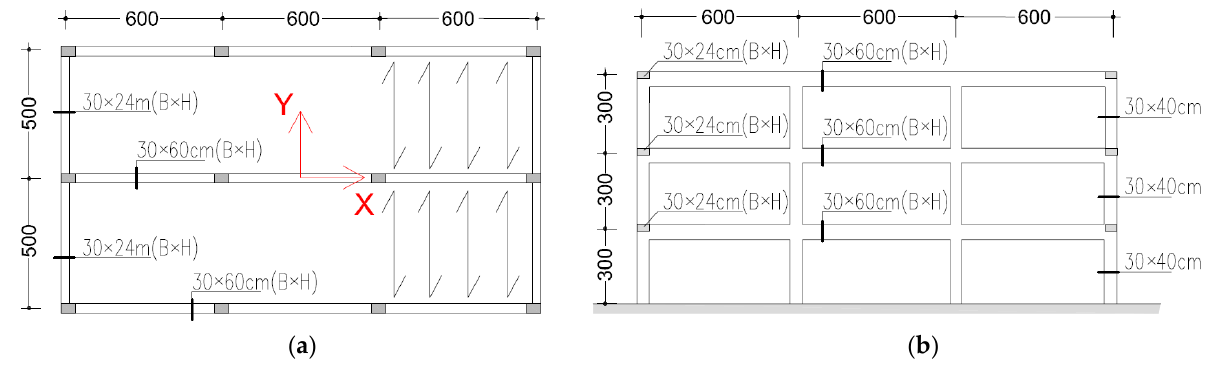
Figure 1. Geometry of the case study building. ( a ) Plan view; ( b ) Lateral view.